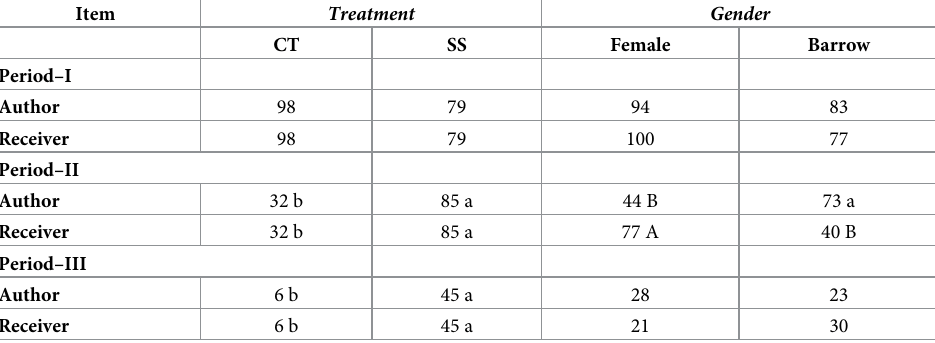
Table 4. Number of agonistic interactions of growing and finishing pigs under control (CT) and stress (SS) condi- tions according to treatment and gender.